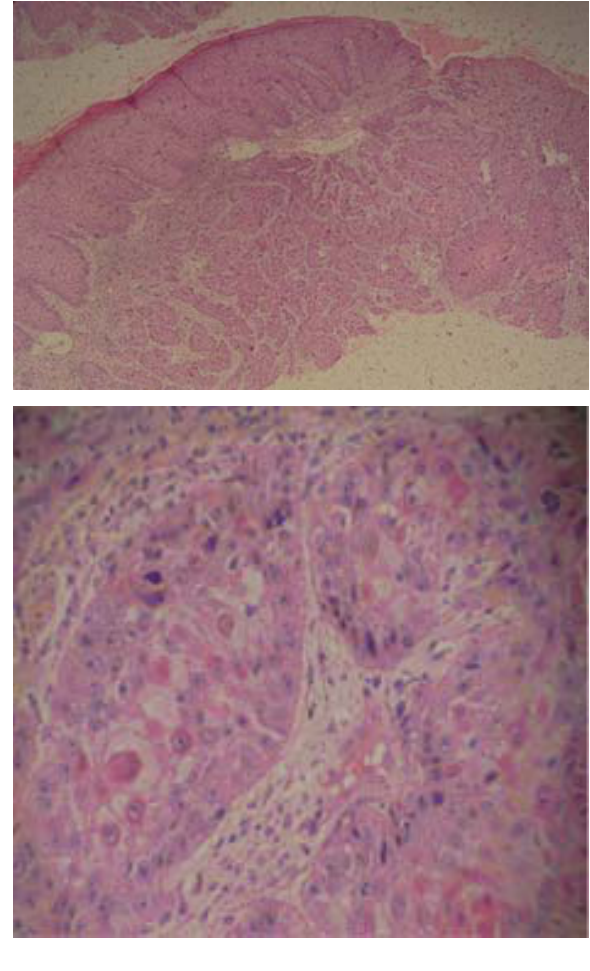
Figure 2. Microscopic fi ndings of the specimen showing vaginal carcinoma in low and high